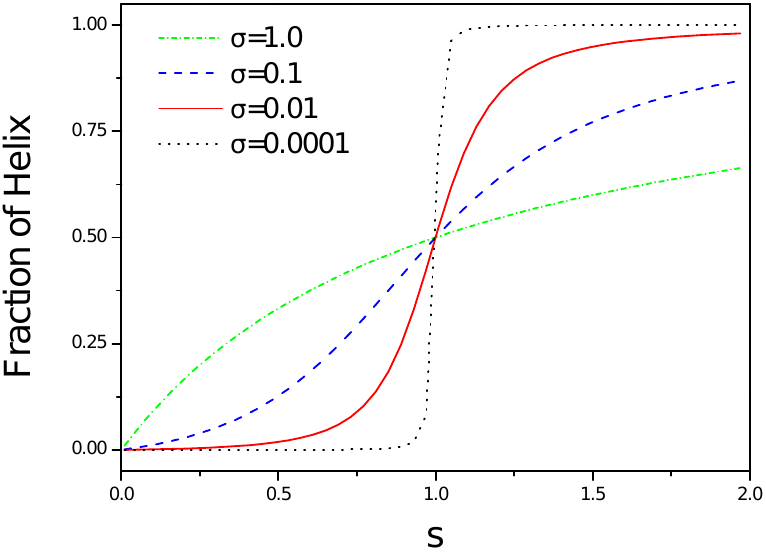
Figure 1. Phase diagrams of structural transition from coil to helix for different interactions. The number of helical state in the block is plotted against s , where s is an equilibrium constant for a coil state converting into a helical